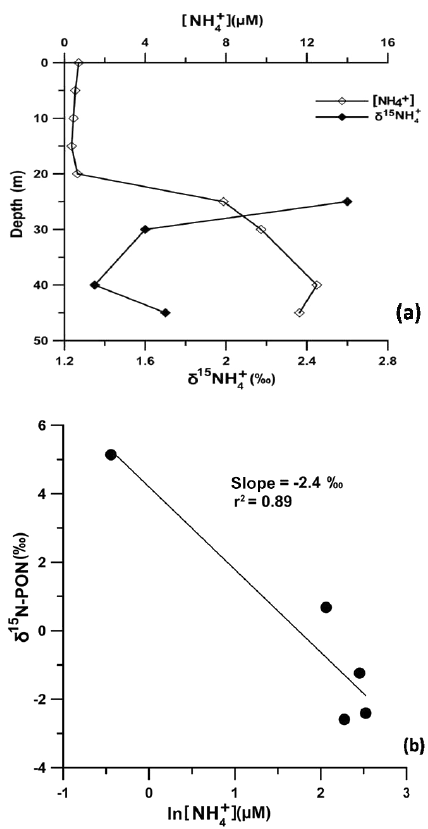
Figure 5. (a) Depth-wise variations of ammonium concentration and δ 15 N–NH + in May 2012. (b) Plot of δ 15 N PON vs. ln(NH + 4 The negative linear correlation yields a fractionation factor ( ε ) of − 2.4‰. Each data point represents a single